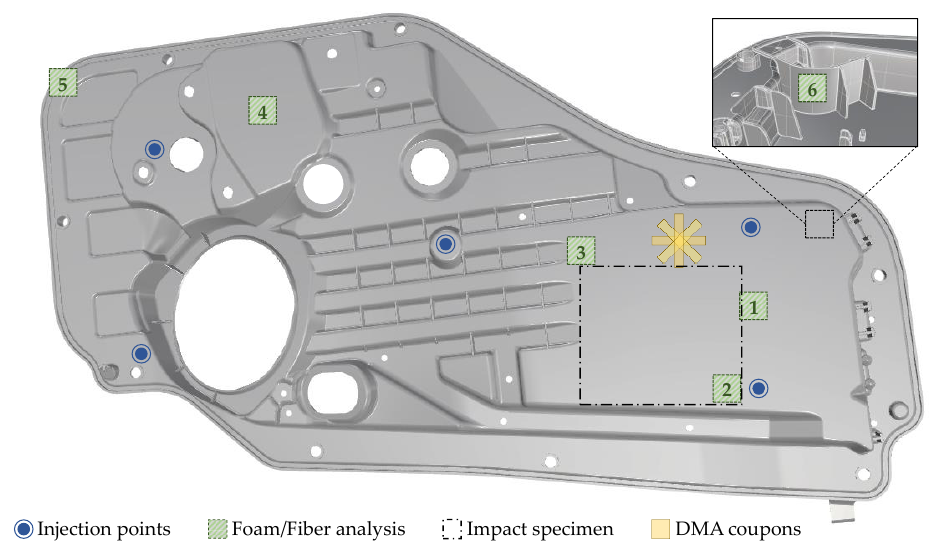
Figure 2. Investigated door panel. Sampling locations 1-6 for full fiber microstructure analysis (FL, FC, FO) and foam analysis. DMA test specimen highlighted in yellow, and impact specimen indicated with a black rectangle were extracted from the panel.